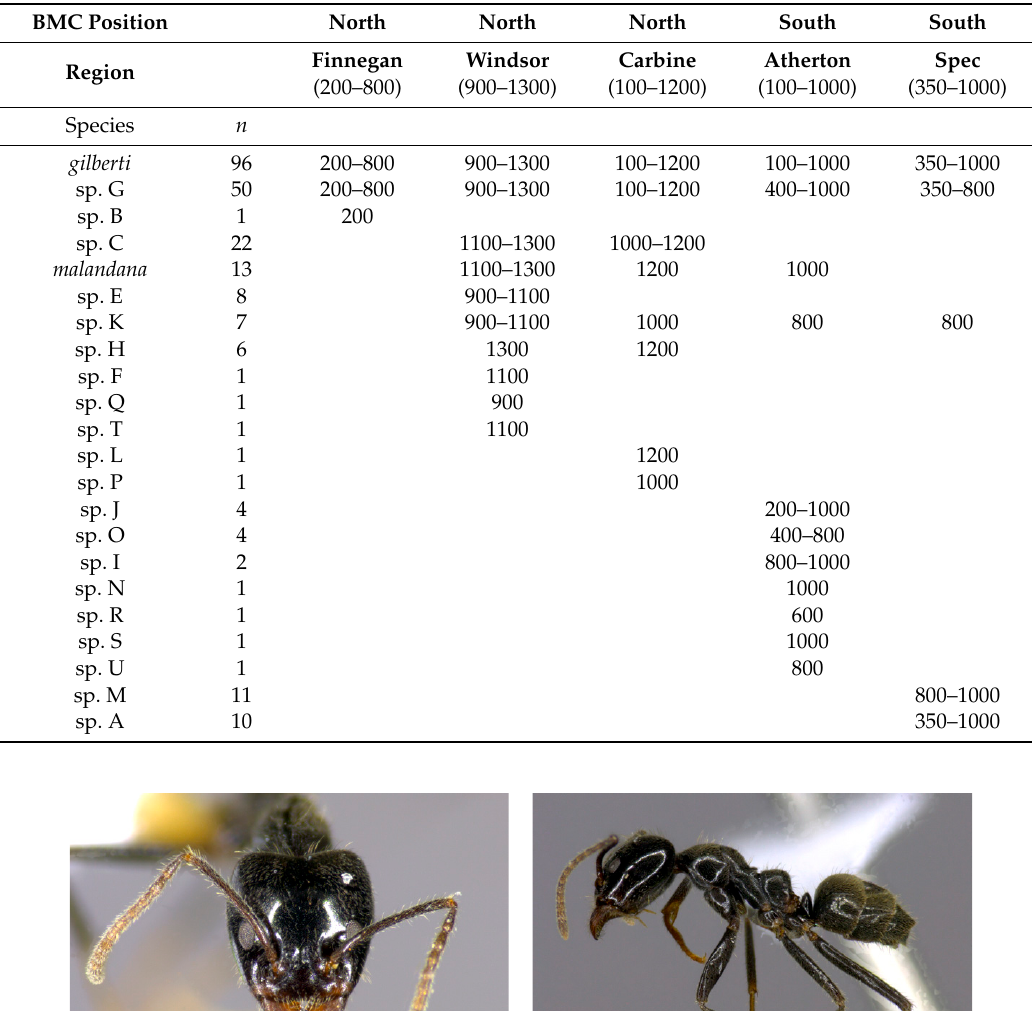
Table 1. The subregion locations and elevation range (maximum–minimum elevation) and number of survey points of 22 species of Anonychomyrma in the Australian Wet Tropics, species are ordered from their north to south subregion distribution, and then by number of survey points, n indicates number of survey points. BMC position indicates the positions of each subregion north or south of the Black Mountain Corridor, a well-known biogeographic barrier. The full elevation range of rainforest habitat is shown in brackets for each subregion.